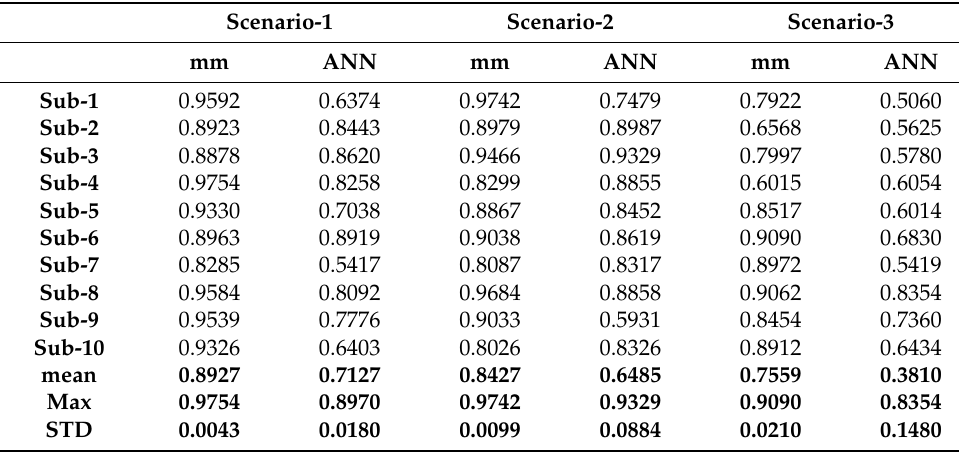
Figure 8. The Representative performance of the multimodel approach compared with ANN. Table 2. Evaluation of the performance in terms of R 2